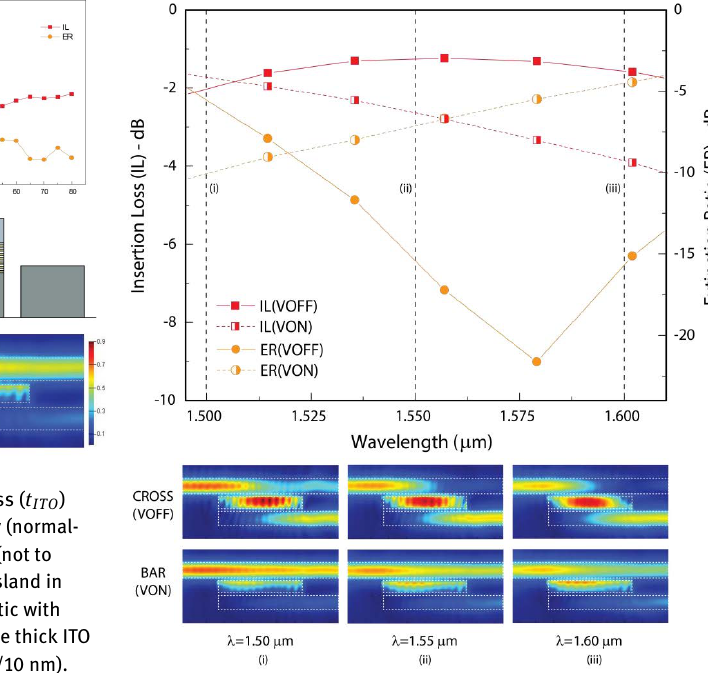
Figure 4: Broadband switch performance for the multi-layer design. Seven SiO 2 /ITO layers with d SiO 2 = 2 nm, t ITO = 10 nm for each are implemented. h WG = 250 nm, W WG = 450 nm, g = 100 nm h island = 160 nm, W island = 300 nm, are used for the device geometry, and the spectral dependent range of complex refractive indices of Alu- minum is from 1.228 − 13.146i to 1.898 − 19.171i after ref